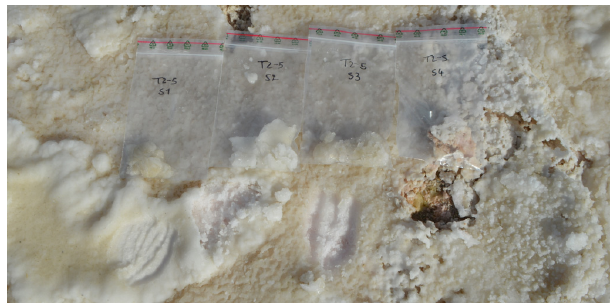
Figure 5. Examples of salt samples collected from the salt crust at site T2-5 P3 at Owens Lake,